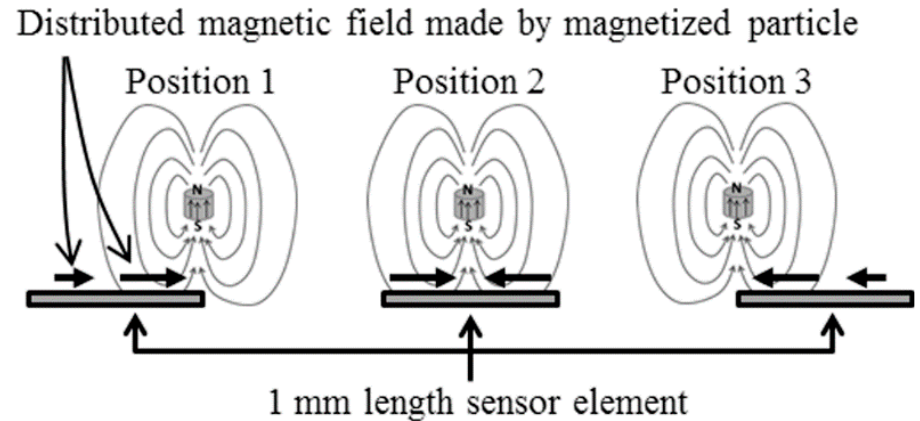
Figure 6. Explanation of interaction between the magnetized particle and thin film sensor in a ver- magnetic field tical magnetic field [21].